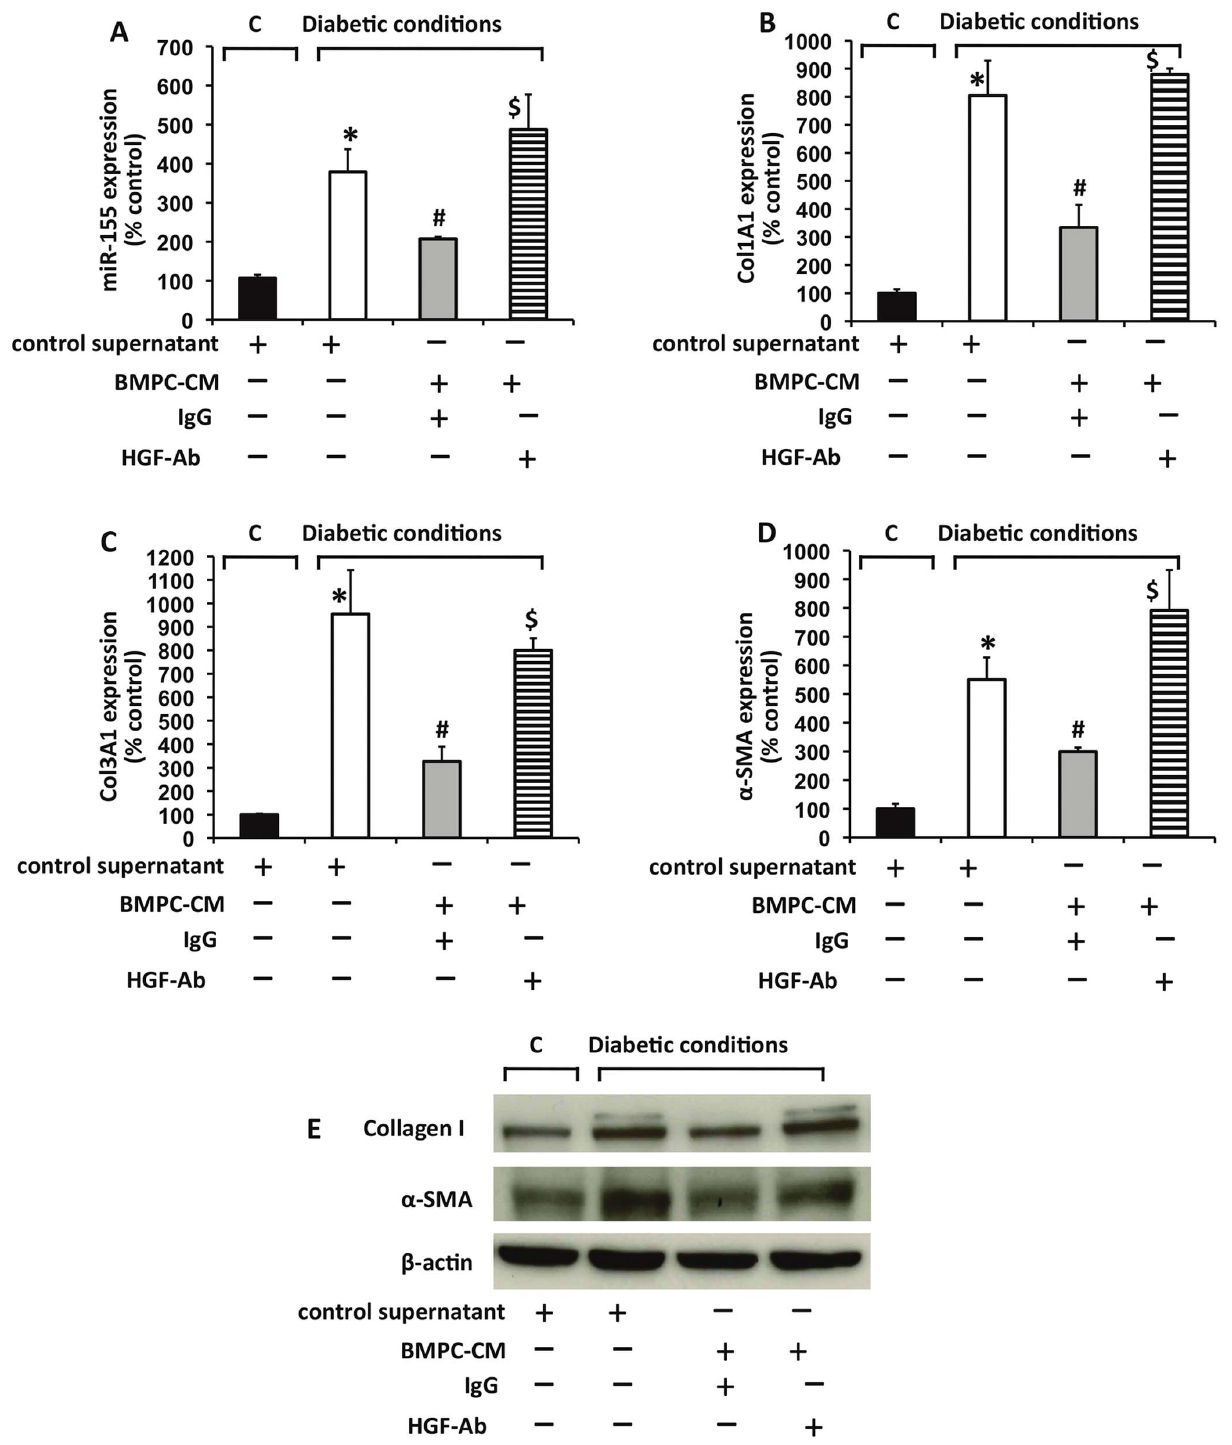
Figure 2. Conditioned media from BMPC regulates miR-155 expression and fibrogenic response in mouse cardiac fibroblasts invitro . ( A ) conditioned media (CM) from BMPC reduced miR-155 expression ( A ) and mRNA expression of fibrogenesis markers like collagen type1 alpha 1(col1A1) ( B ), col3A1 ( C ) and a -SMA ( D ) in mouse cardiac fibroblasts induced under diabetic condition [TGF-beta (10 m g/mL + high glucose (25 mM glucose)]. Neutralizing antibodies against HGF (HGF-Ab) reversed this effect as compared to IgG treated cells. * P , 0.01 versus control; # P , 0.05 versus without CM; $ P , 0.05 versus BMPC conditioned media with IgG. E. Protein expression of collagen I and a -SMA in cardiac fibroblasts with miR-155 over-expression was determined by Western blotting. b -actin served as loading controls. C indicates control condition (5.5 mM glucose); BMPC-CM, conditioned media from BMPC; control supernatant, control media; HGF-Ab, antibodies against hepatocyte growth factor; Col1A1, collagen type 1 alpha 1; Col1A1, collagen type 3 alpha 1; a -SMA, alpha smooth muscle actin.